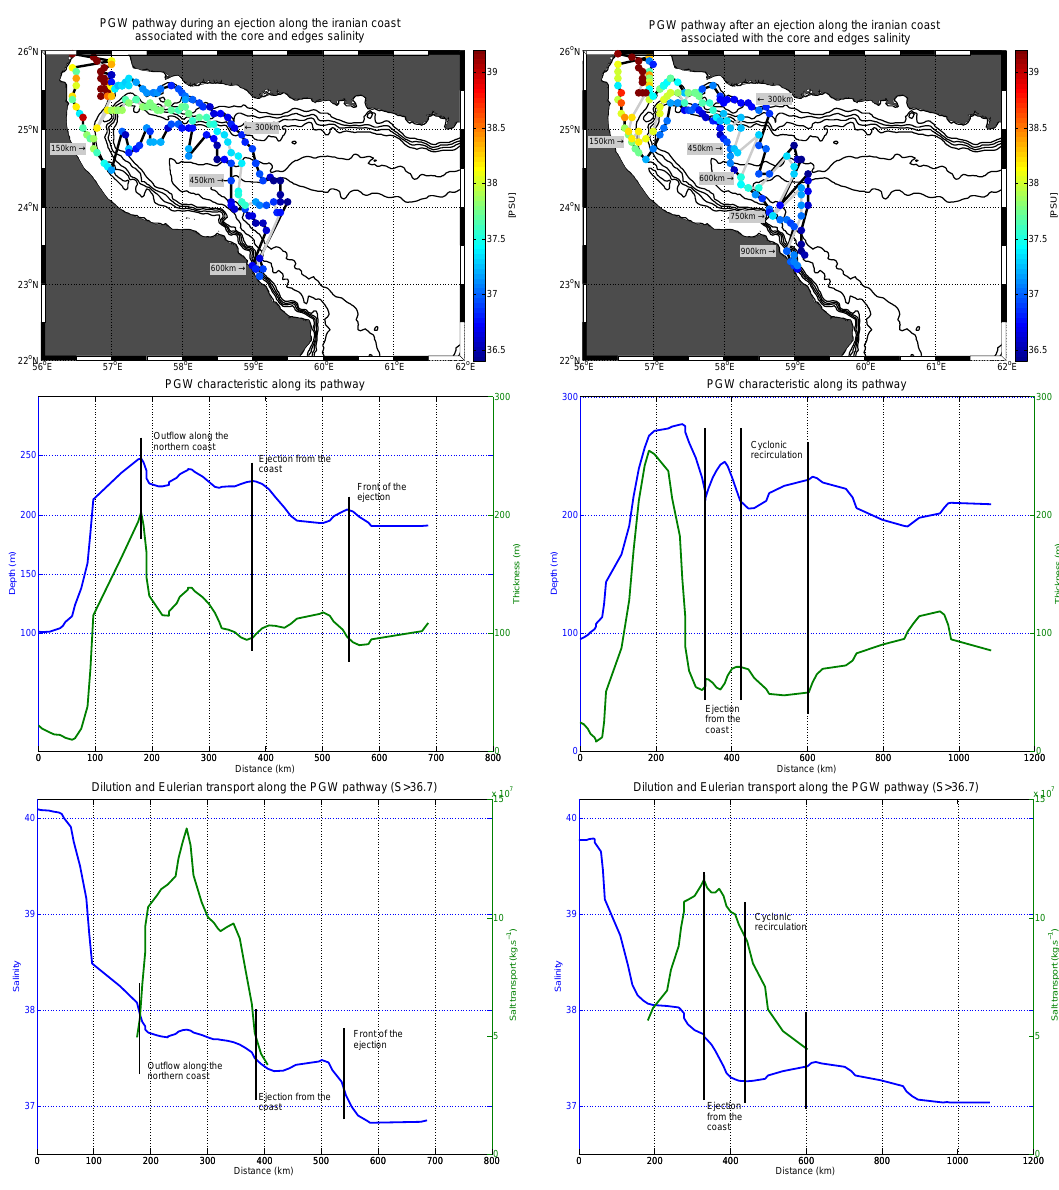
Figure 24. Evolution of the PGW characteristics during the ejection from the northern coast (on 8 April, left) and after (on 30 April, right). The first row shows the pathway of the maximal salinity of PGW and the width of the outflow. The second row displays the depth and thickness of the outflow and the third row maximal salinity and transport of salt along the downstream.